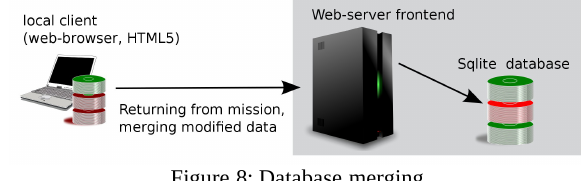
Figure 8: Database